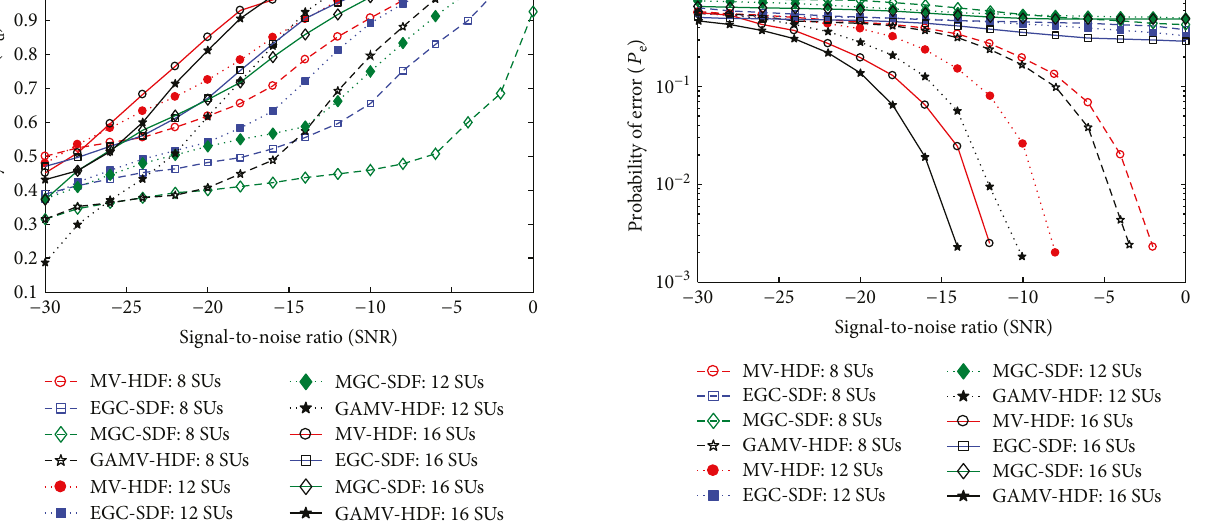
Figure 9: The probability of detection versus signal-to-noise ratio at di ff erent ratios of cooperative SUs with MUs having high SNR compared with SUs.